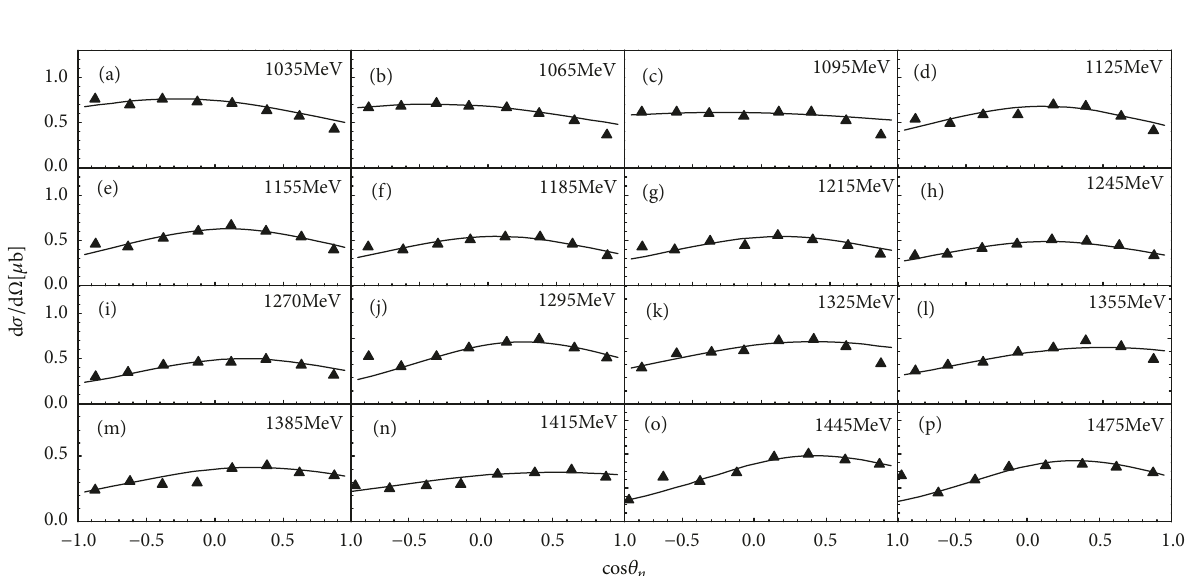
Figure 2: Same as Figure 1, but showing angular distributions for different bins of incident photon energy 1035 MeV ≤ E 𝛾 ≤ 1475MeV.